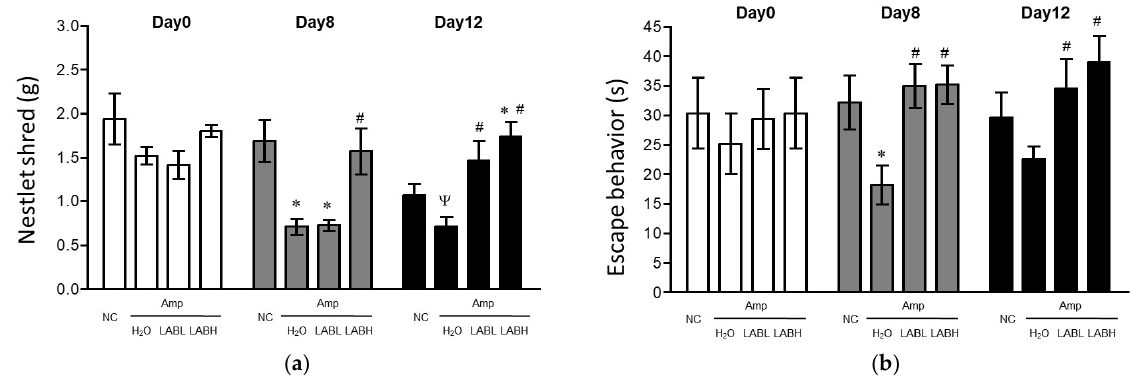
Figure 2. Assessment of the effects of Lactobacillus spp. on depression behaviors in C57BL/6 mice. C57BL/6J mice were grouped into the normal control (NC) group ( n = 9) and Amp group (Amp, n = 10). The groups treated with a composite formula that combined three strains were fed a dose of 1.6 × 10 8 CFU/mouse (low dosage, LABL, n = 12) or 4.8 × 10 8 CFU/mouse (high dosage, LABH, n = 12) from the 3rd day until the 7th day. All groups were assessed for depressive behavioral changes on the initial (0), 8th and 12th days. Behavioral tests for depression included the nest − building test and forced swimming test. ( a ) Quantification of Nestlet Shredding. ( b ) Quantification of Escape behavior. *, compared with NC group, p < 0.05; #, compared with Amp group, p < 0.05, Ψ , compared with LABL group, p < 0.05.